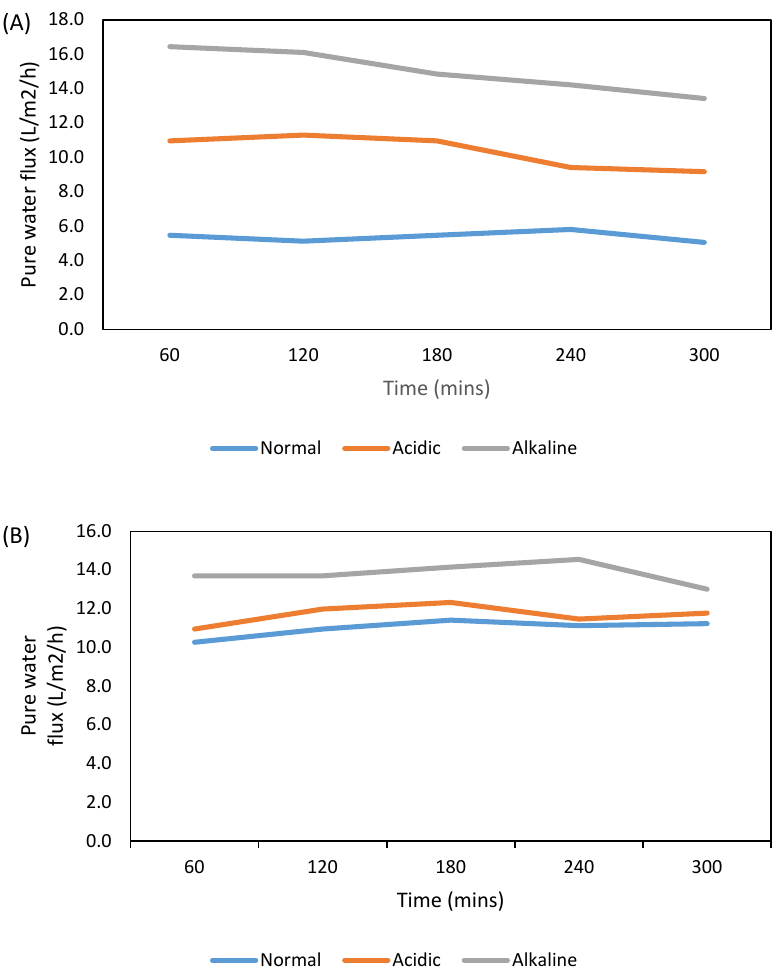
Figure 5. Water flux for PA ( A ) and PA-CNC ( B ) at 7 bar after soaking for two weeks in 1 M HCl (acidic) and 1 M NaOH (alkaline) solutions.